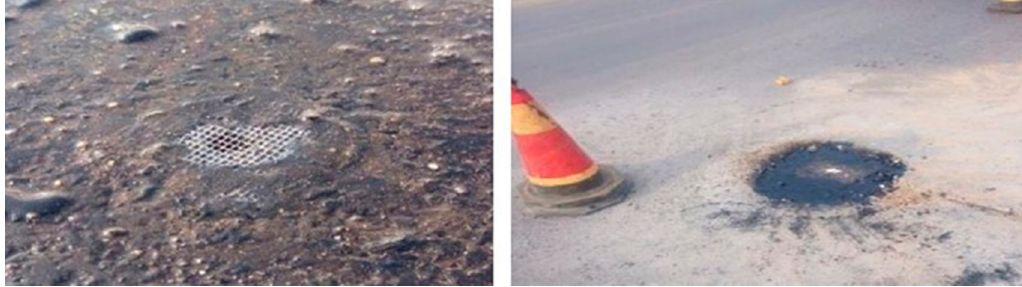
Figure 4. The photo of field measurement.